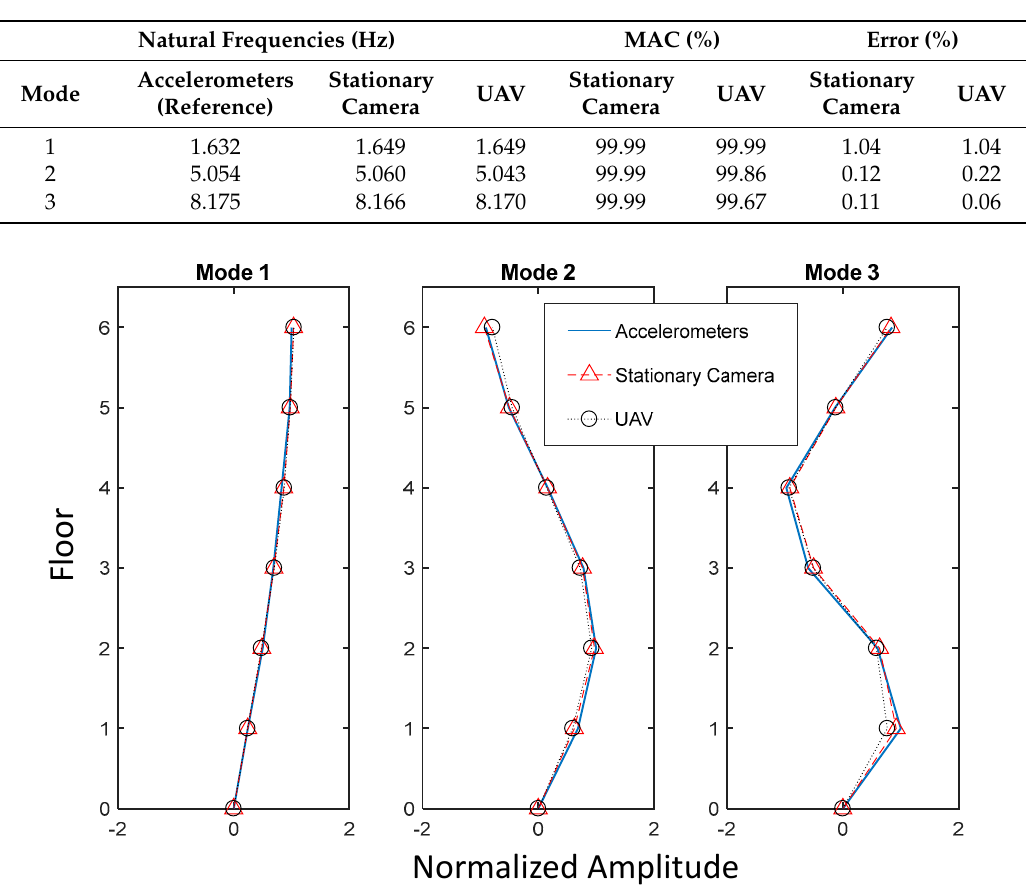
Figure 9. Comparison of mode shapes.